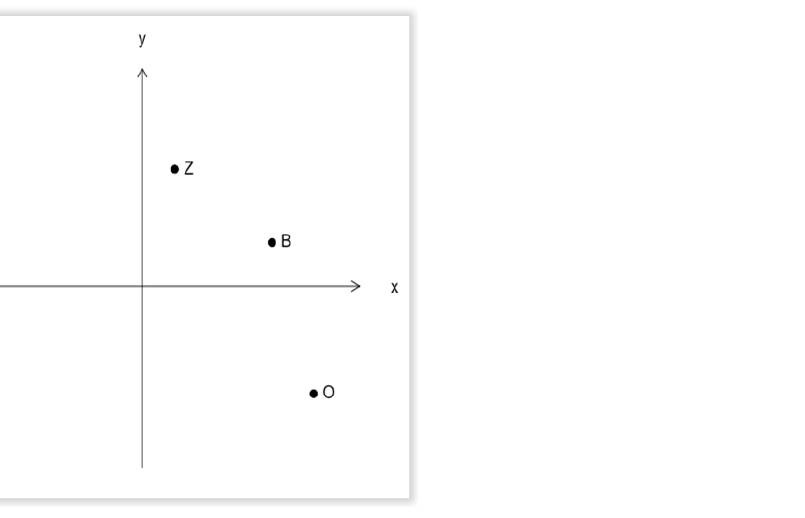
A5 displays the individual two-dimension solution MDS for each mare. They showed the same per- Figure 7. Perceived similarity among five letters. A two-dimensional MDS solution was applied to ceived similarity). the dissimilarity matrix (see Table 2) calculated from the combined data of the four mares. (Figure S5